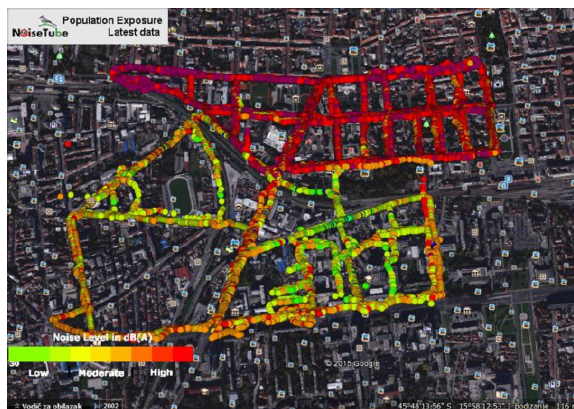
Figure 7. The original measurements displayed in Google Earth (Vuković et al., 2015b)